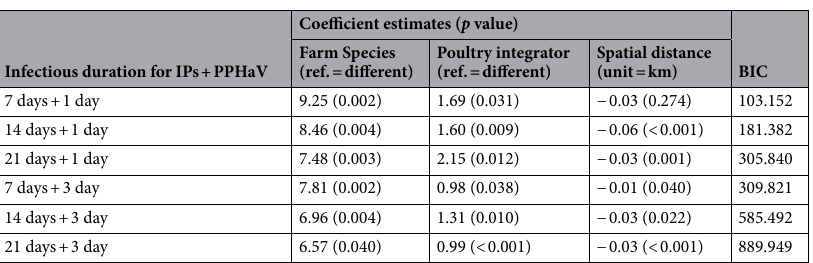
Table 2. Association between three dyadic explanatory variables and a tie formation between the same genotype IPs under the different infectious duration for infected premises and vehicle movements using logistic regression quadratic assignment procedure (LQ-QAR). IPs infected premises, PPHaV poultry production and health associated vehicles, ref reference, BIC Bayesian information criterion.